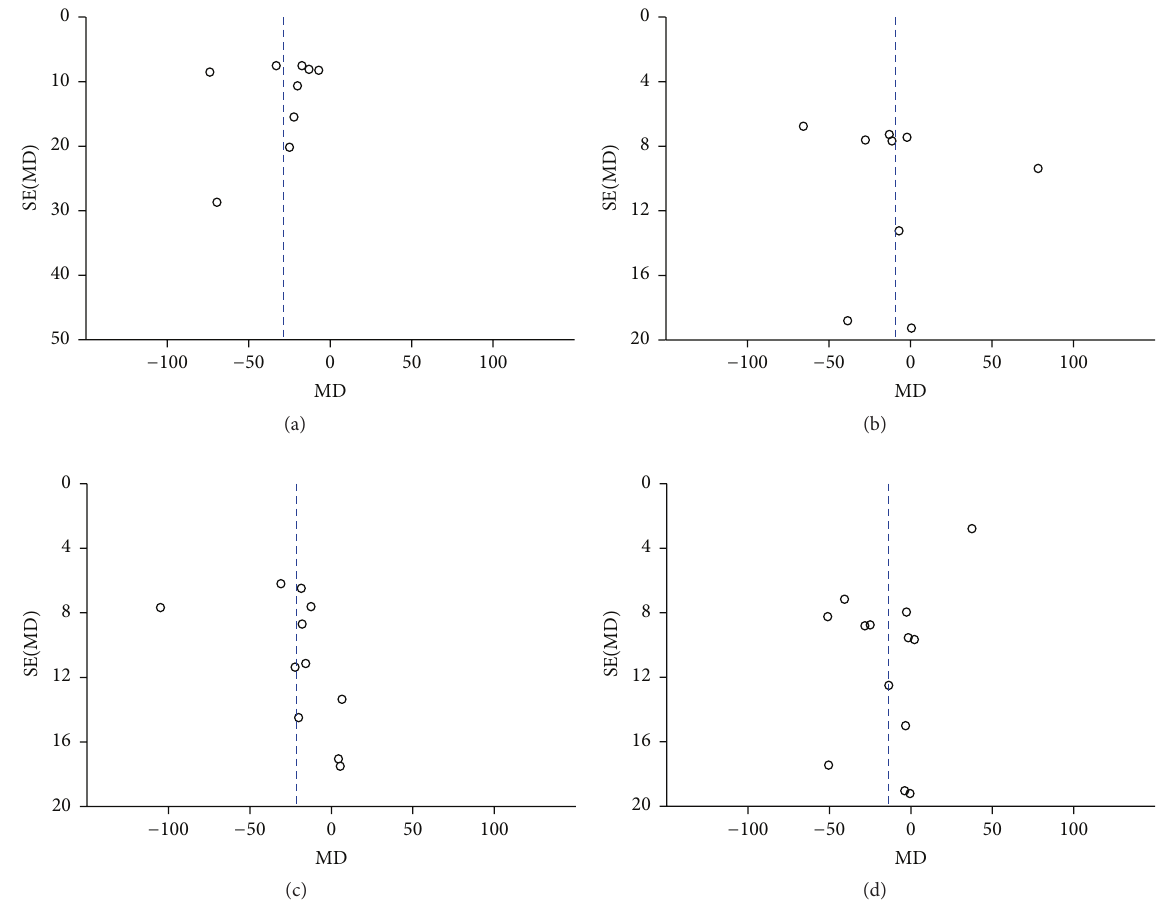
Figure 8: Funnel plots for evaluating the publication bias of PPCT in each sector: (a) superior, (b) inferior, (c) nasal, and (d) temporal.